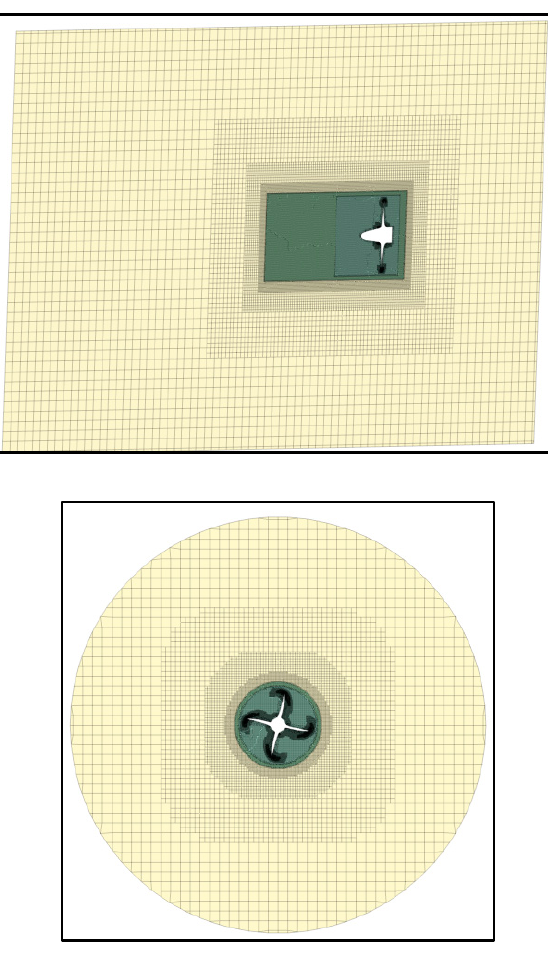
Figure 3. Grid resolution inside the computational